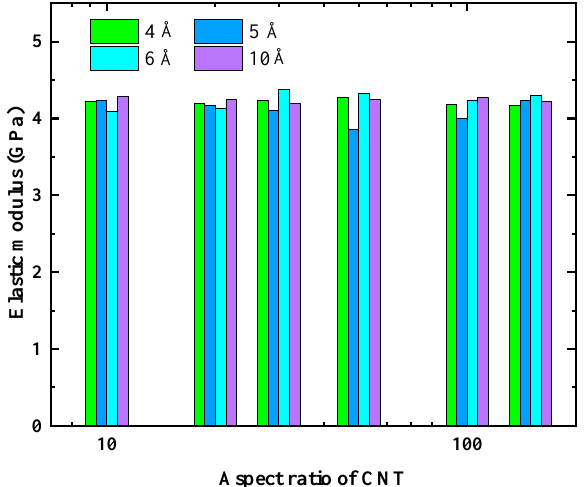
Figure 7. Averaged lateral elastic moduli of epoxy-matrix nanocomposites reinforced by the CNTs which have different aspect ratios and various degrees of